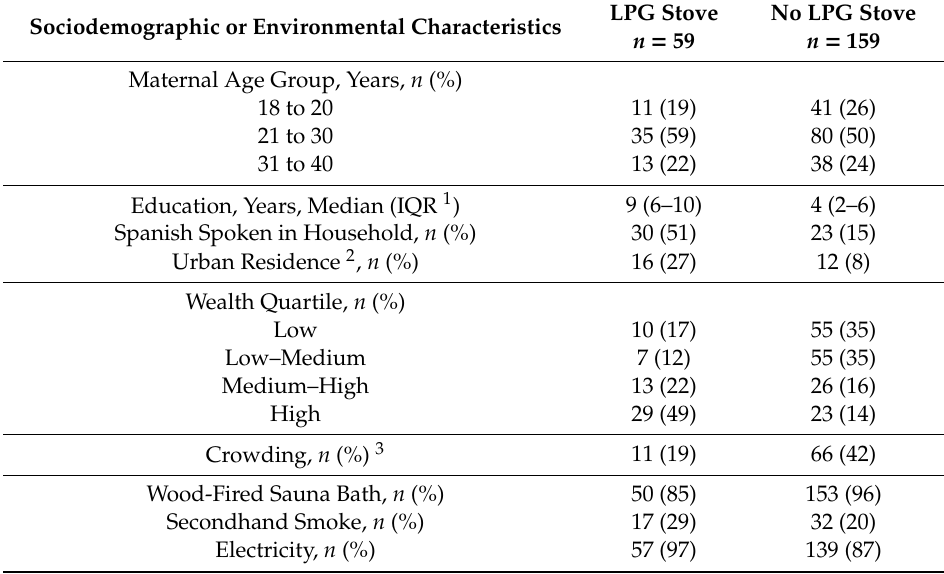
Table 1. Baseline sociodemographic and household environmental characteristics among liquefied petroleum gas (LPG) stove owners and non-owners. Sociodemographic or Environmental